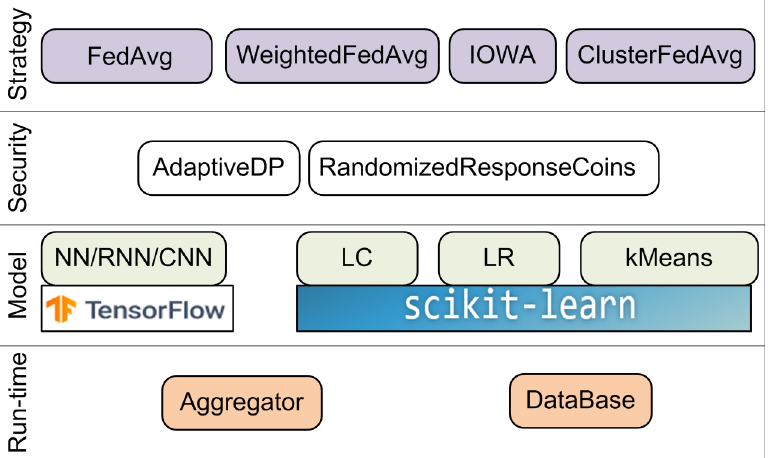
Figure 8. Architecture of the Federated Learning and Differential Privacy (FL&DP)